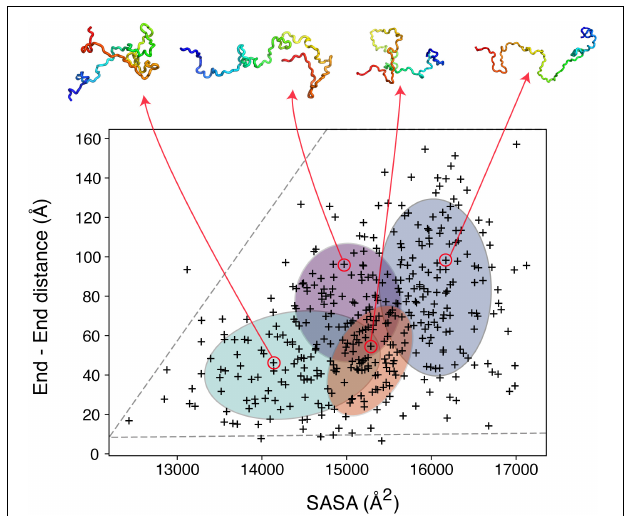
FIGURE 3 | Clustering IDP ensembles using machine learning. A Bayesian Gaussian mixture model to classify an α Syn ensemble that consists of 400 structures based on their end-to-end distance and solvent accessible surface area (SASA). The four ellipses correspond to the four clusters identified with four structures shown as examples above. The ensemble used for this analysis (PED00024) was generated by Allison et al. (2009), using